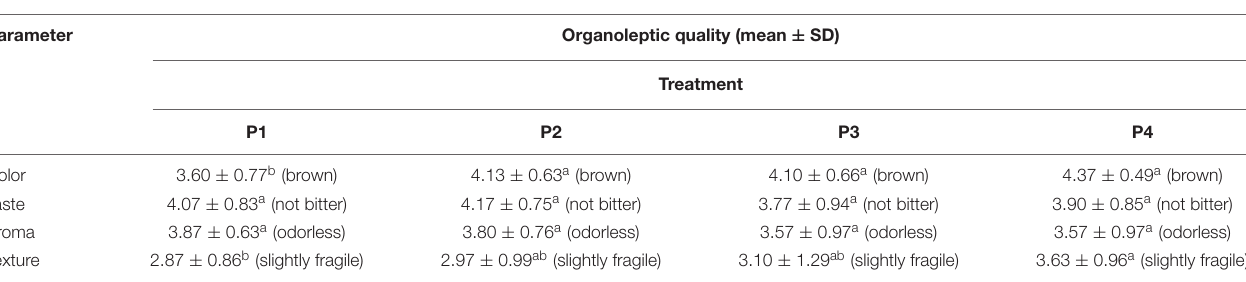
TABLE 4 | The results of the organoleptic evaluation of sagon formulated with lindur and soybean flour.